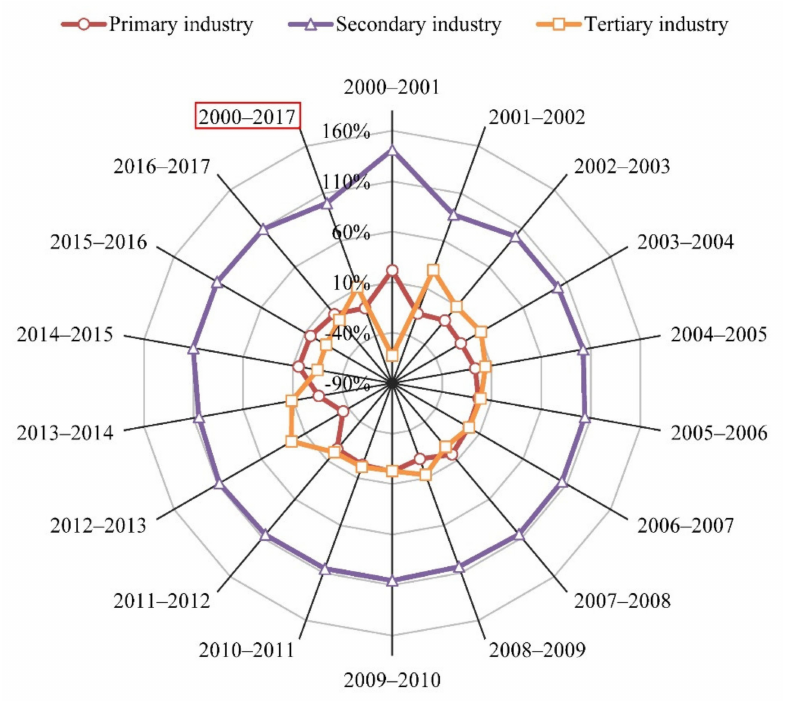
Figure 6. The proportions of industrial structure effect of each industry in Gansu from 2000 to 2017 and the entire